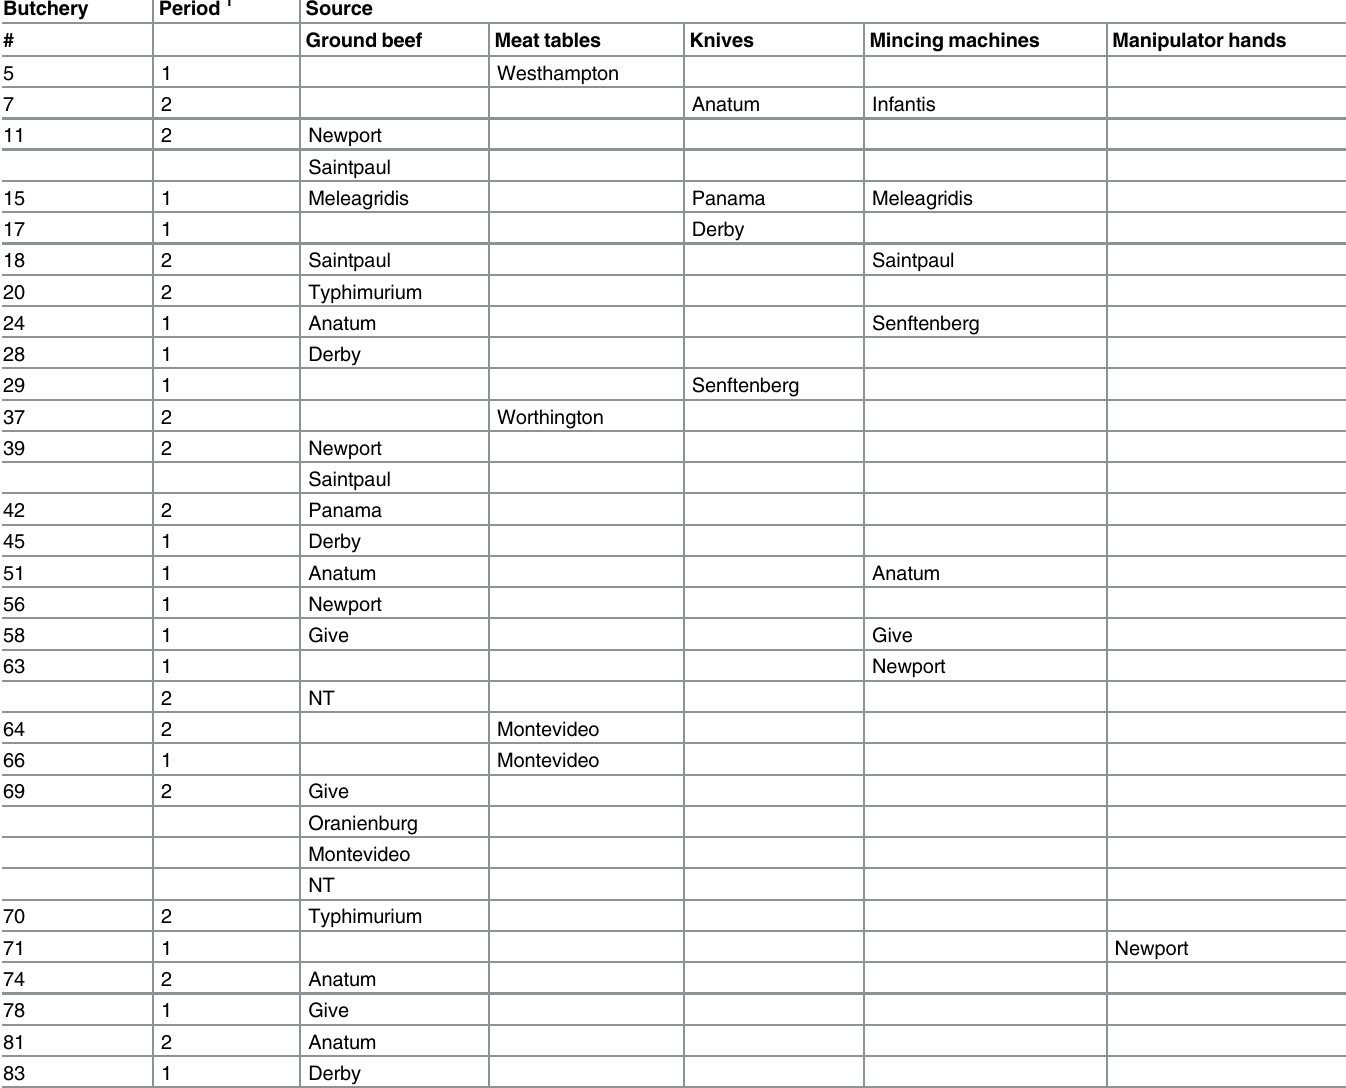
Table 4. Sources of Salmonella spp. serovars isolated during both study periods. Butchery Period